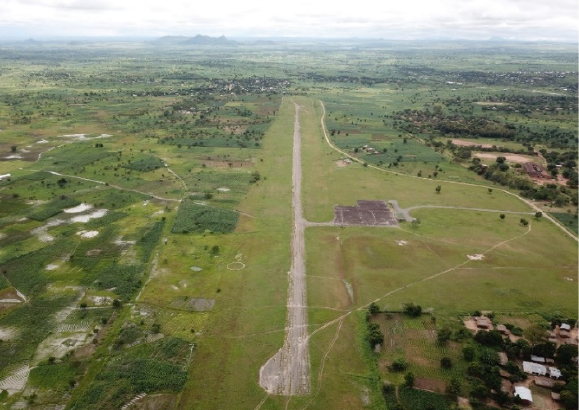
Figure 1 . The district of Kasungu, with the UAV runaway located at the center of the